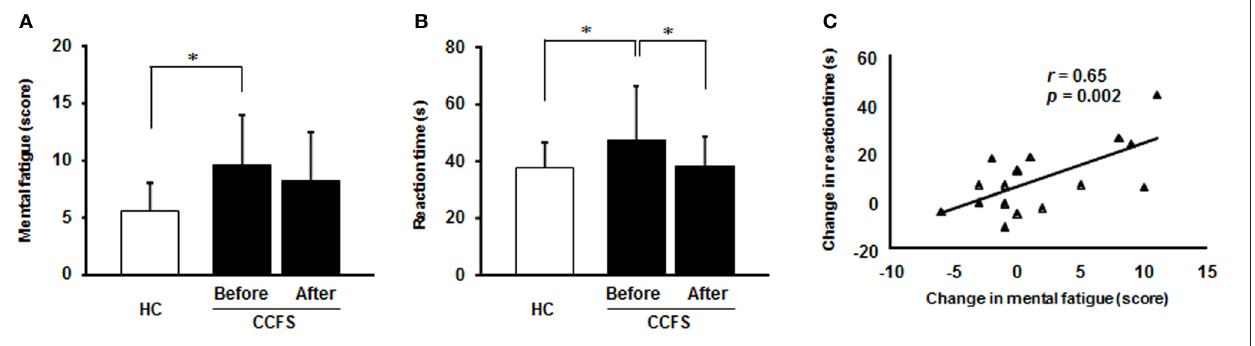
FIGURE 1 | Effects of combination treatments of cognitive behavioral therapy and antidepressant medication (fluvoxamine) for 6 months on (A) the severity of mental fatigue and (B) task performance on a attention switching task in patients with childhood chronic fatigue